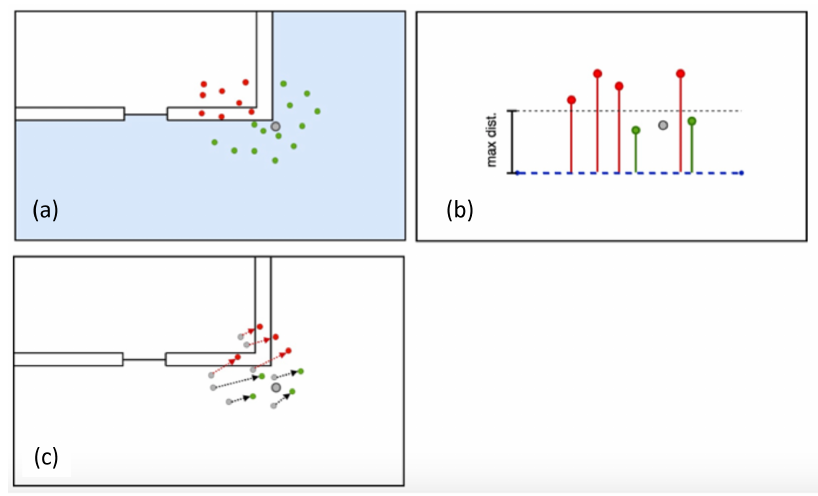
Figure 5. Overview of the used filtering methods, with the cm in ( a ), cr in ( b ), and cl in ( c ). The underlying algorithm of the backtracking segment is presented in Algorithm